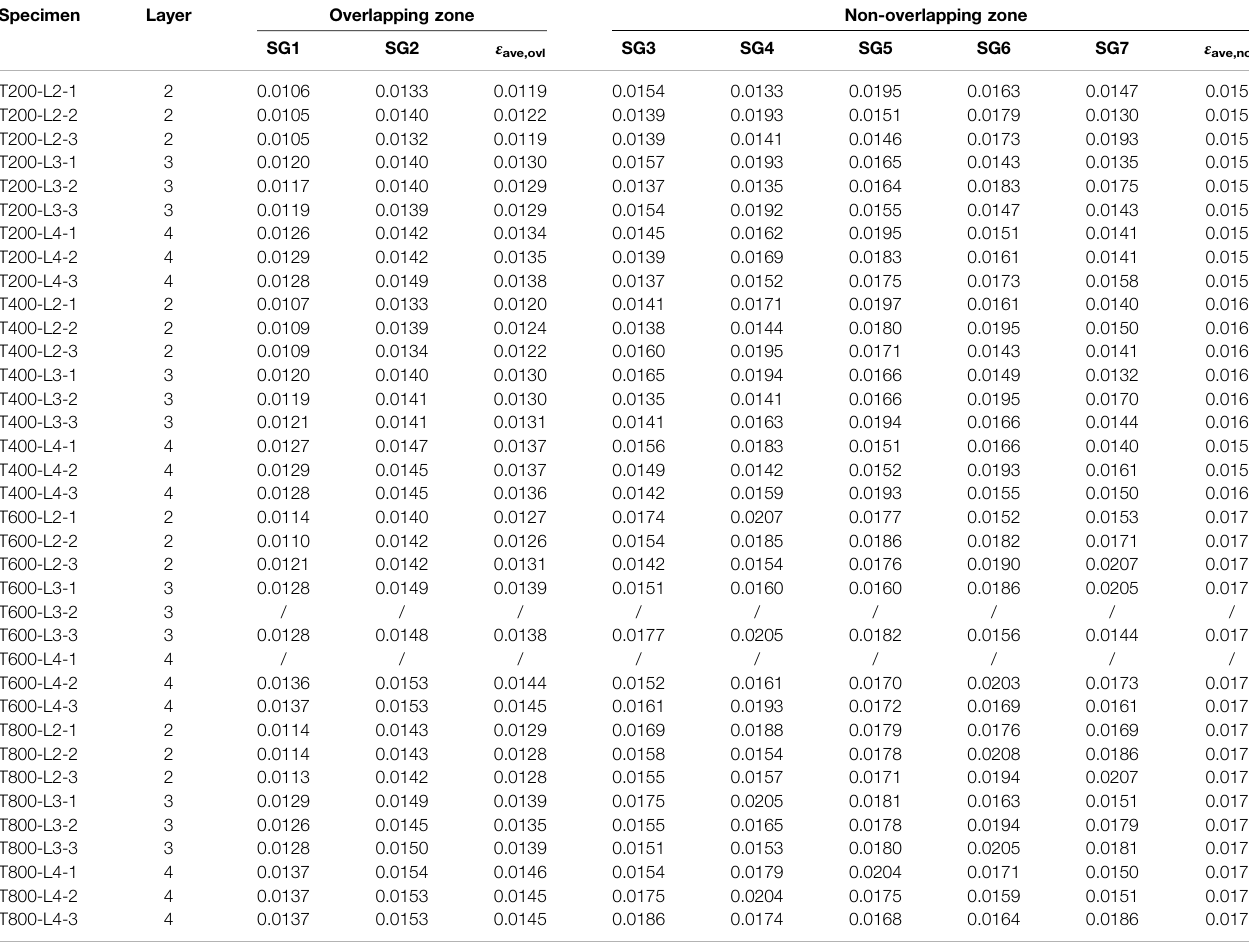
TABLE 3 | Hoop strain responses at the ultimate condition.